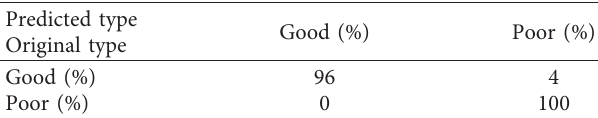
Table 6: Prediction rate of regression model between the two